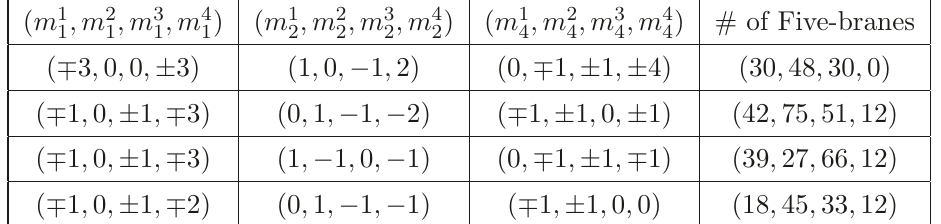
Table 5 . Number of heterotic five-branes in the basis ( w 1 , w 2 , w 3 , w 4 ) and the first Chern numbers c i ( L a ) = m i in agreement with all the requirements, where other line bundles are constrained as a 1 c 1 ( L 5 ) = c 1 ( L 4 ) and c 1 ( L 3 ) = 0. We omit the other sign flipping and possible −